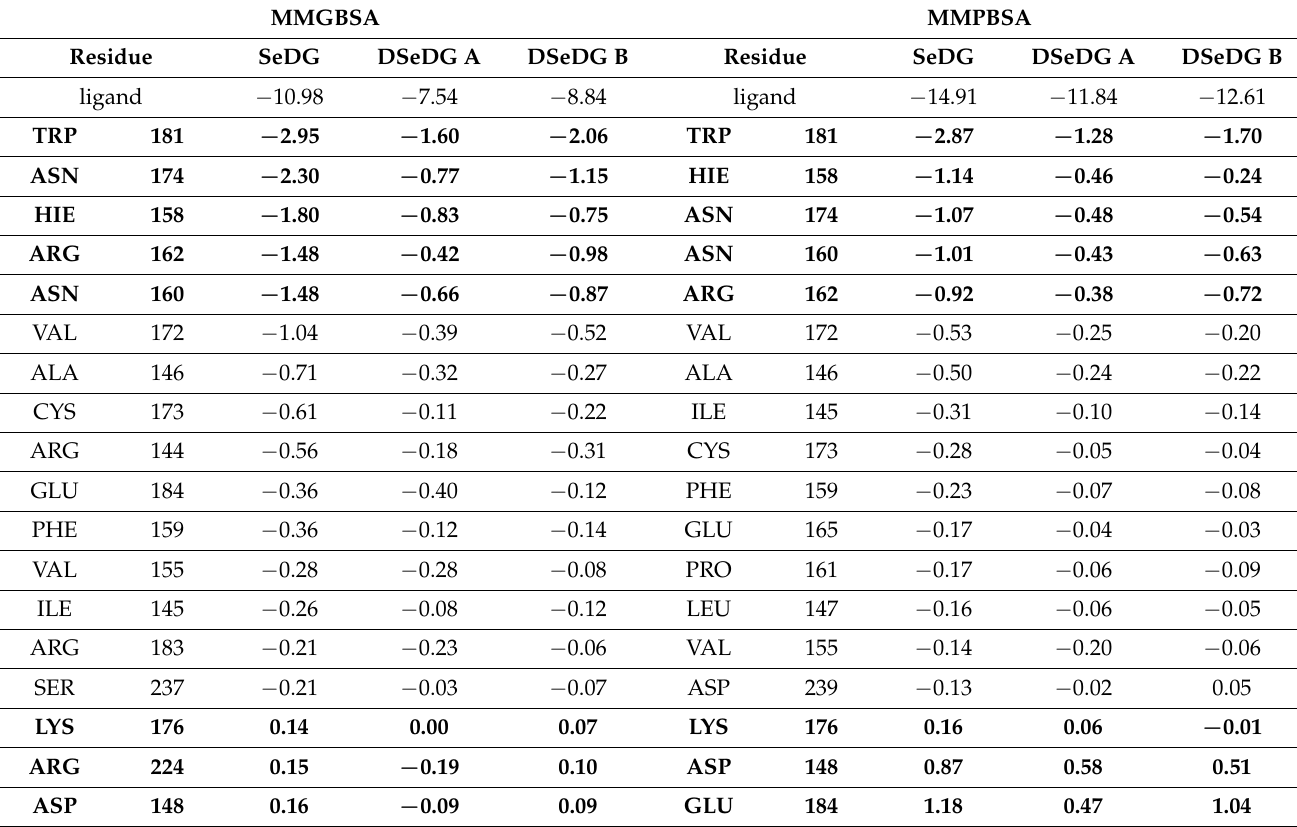
Table 2. Decomposition of enthalpic contributions of individual residues to the overall binding enthalpy sorted according to the values of